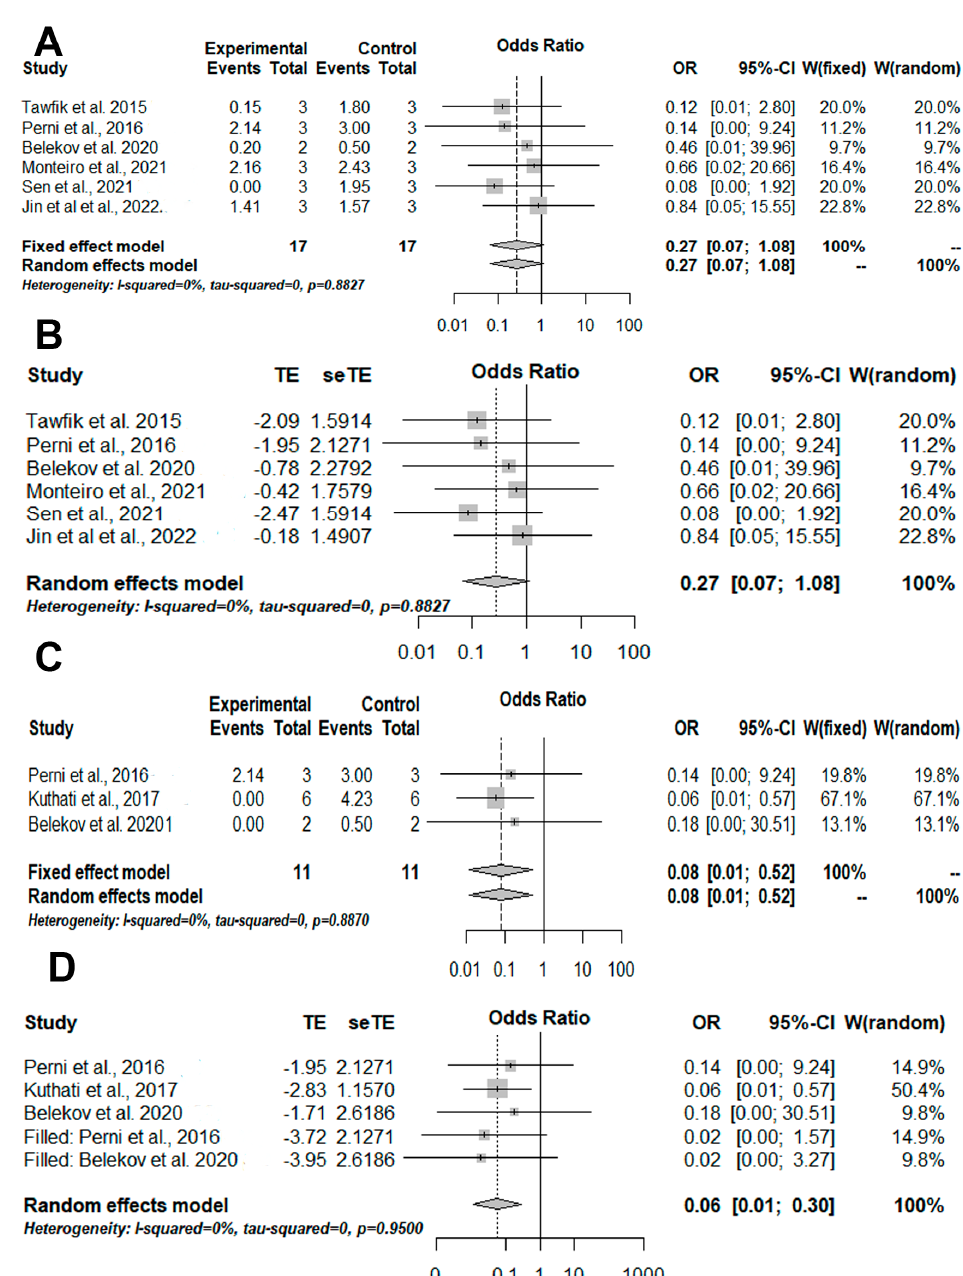
Figure 3. Illustration of meta-analysis and quantitative approaches. The experimental group was formed by aPDT mediated by photosensitizer conjugated inorganic nanoparticles and the control group was formed by aPDT only. ( A ) The results of the meta-analysis are illustrated in a forest plot for the viability of S. aureus . ( B ) Trim-and-fill results for the viability of S. aureus show the presence of publication biases. ( C ). The results of the meta-analysis are illustrated in a forest plot for the viability of E. coli . ( D ) Trim-and-fill results for the viability of E. coli show the presence of publication and meta-analysis biases. OR = odds ratio; CI = confidence interval; W: weight. TE = estimated mean; seTE = estimated standard deviation [29–31,36,38,40,41].